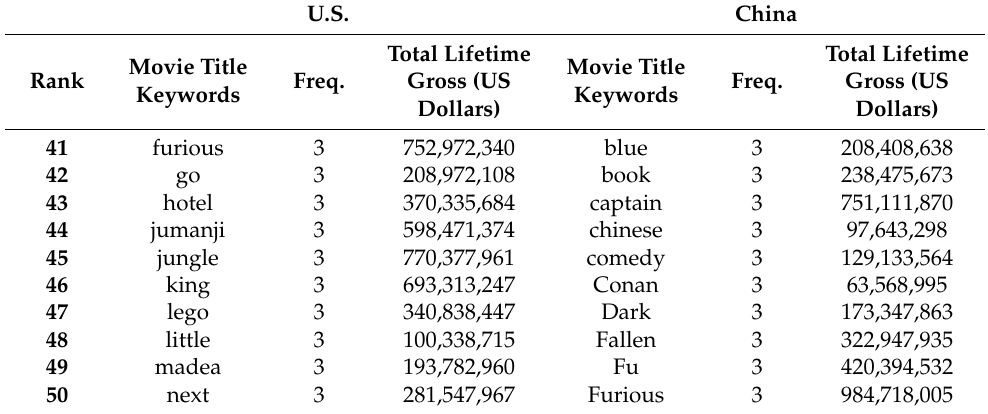
The bar charts of the top 10 movie title keywords in the United States (Figure 3) and